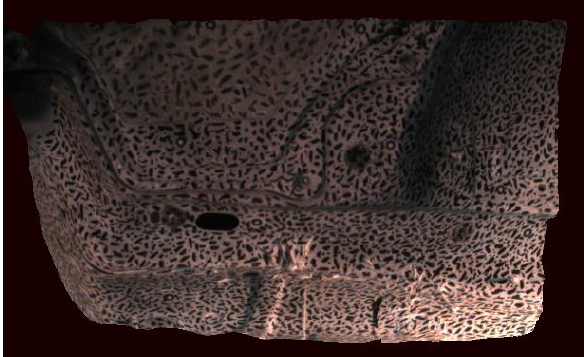
Figure 9. Orthophoto of footwell scene with ground sample distance of 1 mm